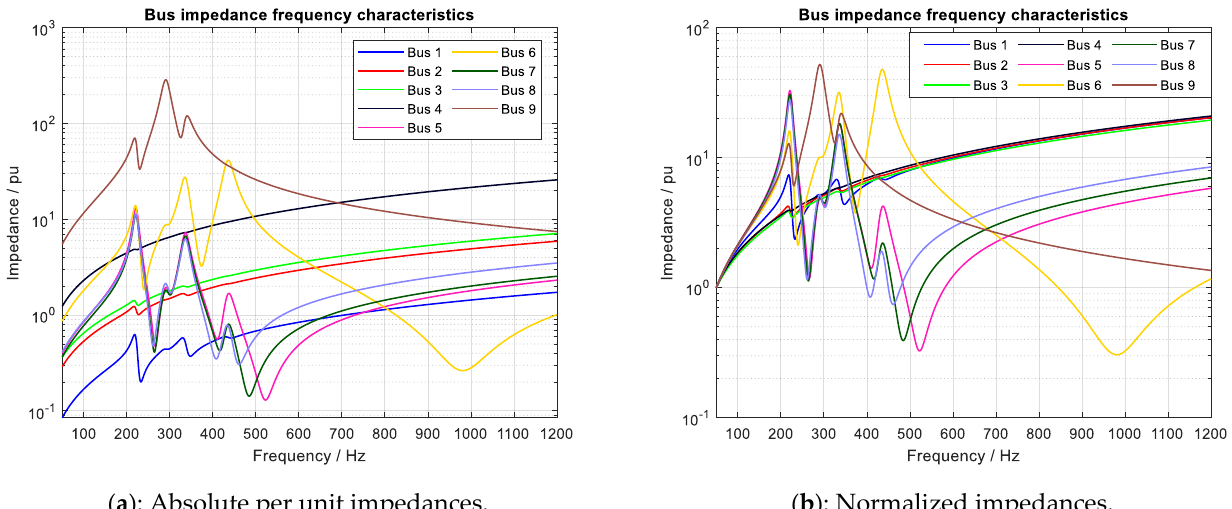
Figure 5. Industrial network impedance frequency scan results. Figure ( a ) represents the absolute impedance values expressed in the per unit system, while figure ( b ) represents the impedance values normalized to the bus impedance at the nominal network frequency.